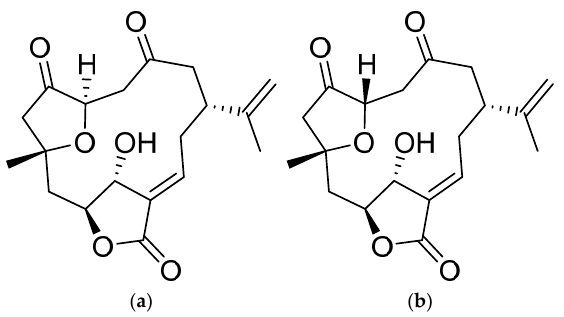
Figure 1. Chemical structure of sinuleptolide ( a ) and 5- epi -sinuleptolide ( b ).